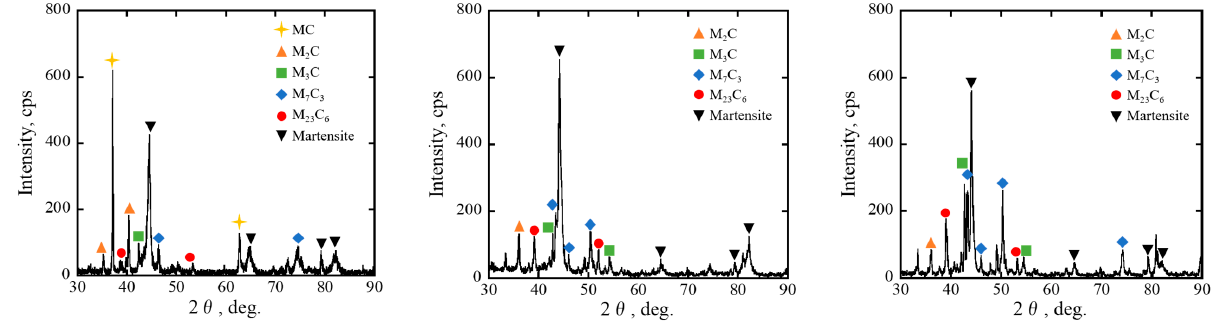
Figure 3. X-ray diffraction patterns of ( a ). MWCI; ( b ). 18Cr MWCI as–Q; ( c ). 27Cr MWCI as–Q.